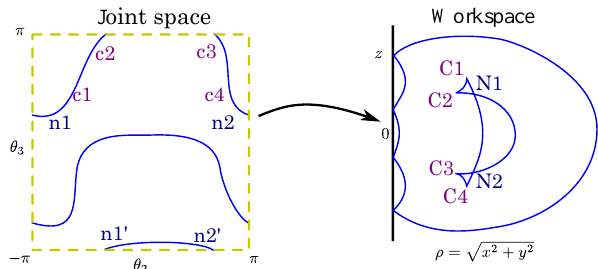
Figure 2. Singular sets in the space of the last two joints ( θ 2 ,θ 3 ) and in the cross section 3R orthogonal manipulator with parameters d 2 = 1, d 3 = 1 . 5, d 4 = 0 . 7, r 2 = 0 . 5, r 3 = 0 .